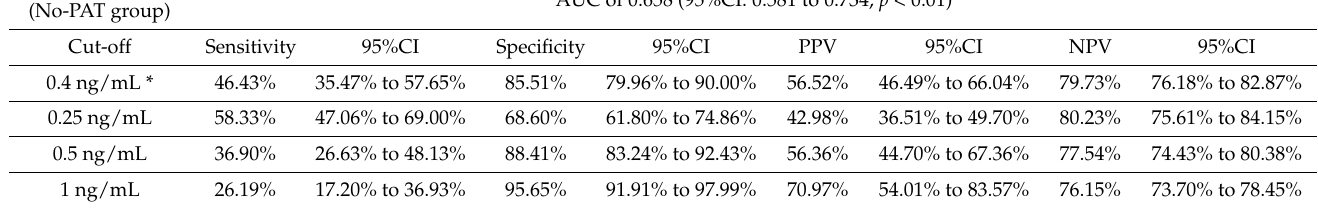
Table 3. Procalcitonin performance (at different cut-off values) in the prediction of antibiotic use (No-PAT group), antibiotic continuation (PAT group), lower-respiratory-tract involvement and radi- ologically confirmed pneumonia. Abbreviations: 95%CI—95% confidence interval, PPV—positive predictive value, NPV—negative predictive value, LRTI—lower-respiratory-tract infection. * Optimal cut-off values according to the Youden